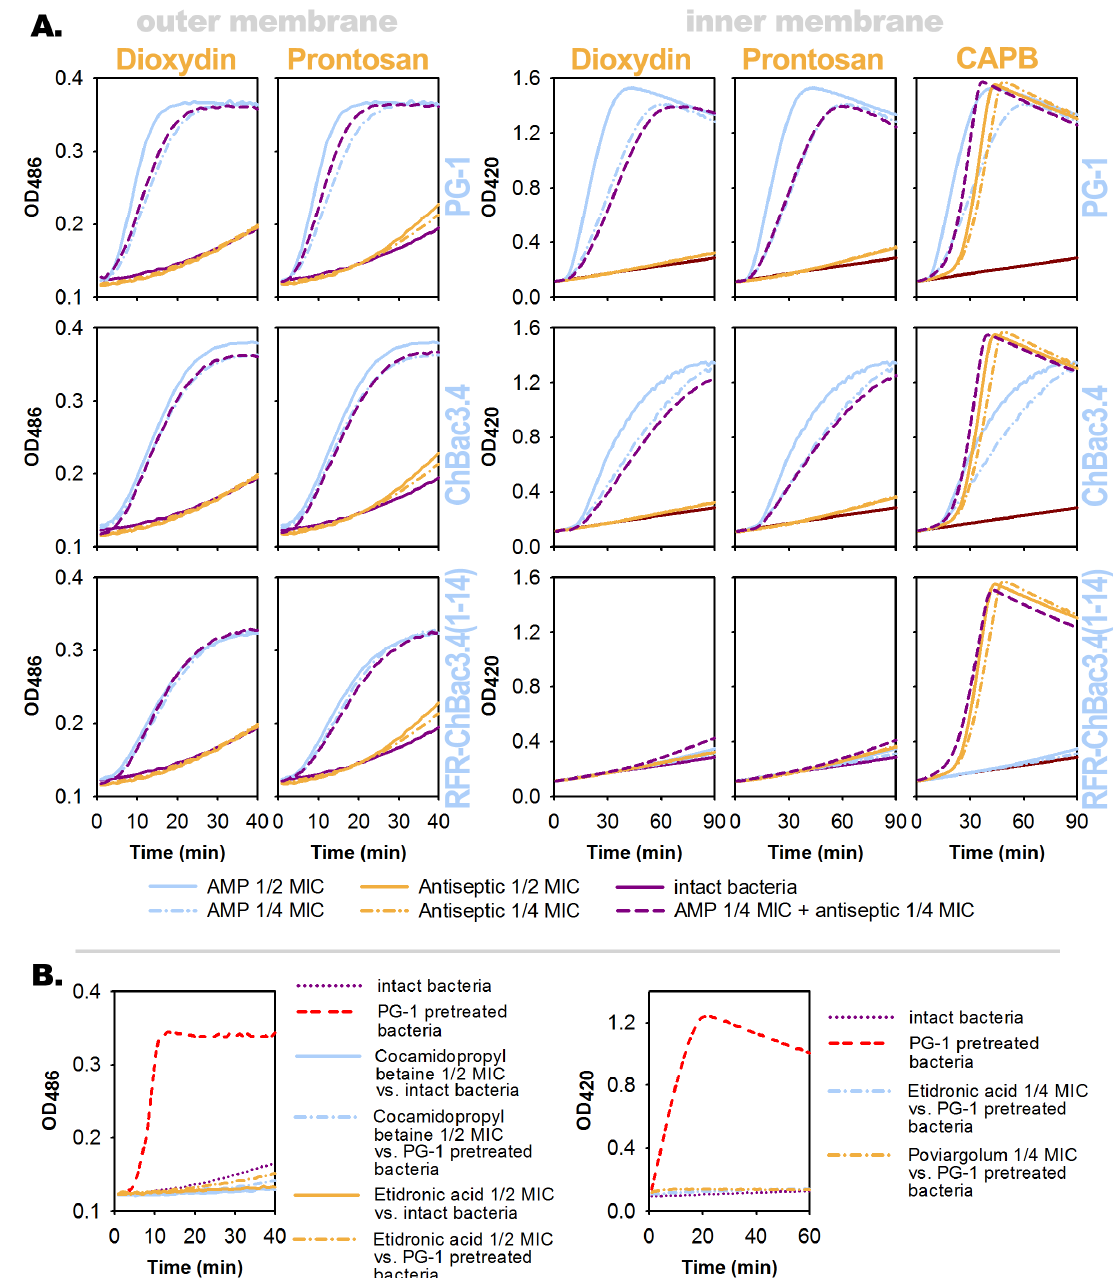
Figure 1. ( A ) Effects of combinations of AMPs with antiseptics and surfactants on membrane permeability of E. coli ML-35p. Individual action of 1 / 4 and 1 / 2 of minimal inhibitory concentrations (MICs) of compounds is compared to that of their combinations containing 1 / 4 MIC of AMP + 1 / 4 MIC of antibiotic/surfactant. Curves illustrate nitrocefin degradation by the bacterial periplasmic β -lactamase (for the outer membrane permeability assessment) or o-nitrophenyl- β -D-galactoside (ONPG) degradation by the bacterial cytoplasmic β -galactosidase (for inner membrane permeability assessment) which occur when the membranes are damaged by test substances. The steeper slope of the curve and the shorter time to reach the plateau level correspond to a greater extent of damage. CAPB—cocamidopropyl betaine. ( B ) Interference of some of the tested compounds with marker molecules’ transformation by bacterial enzymes.